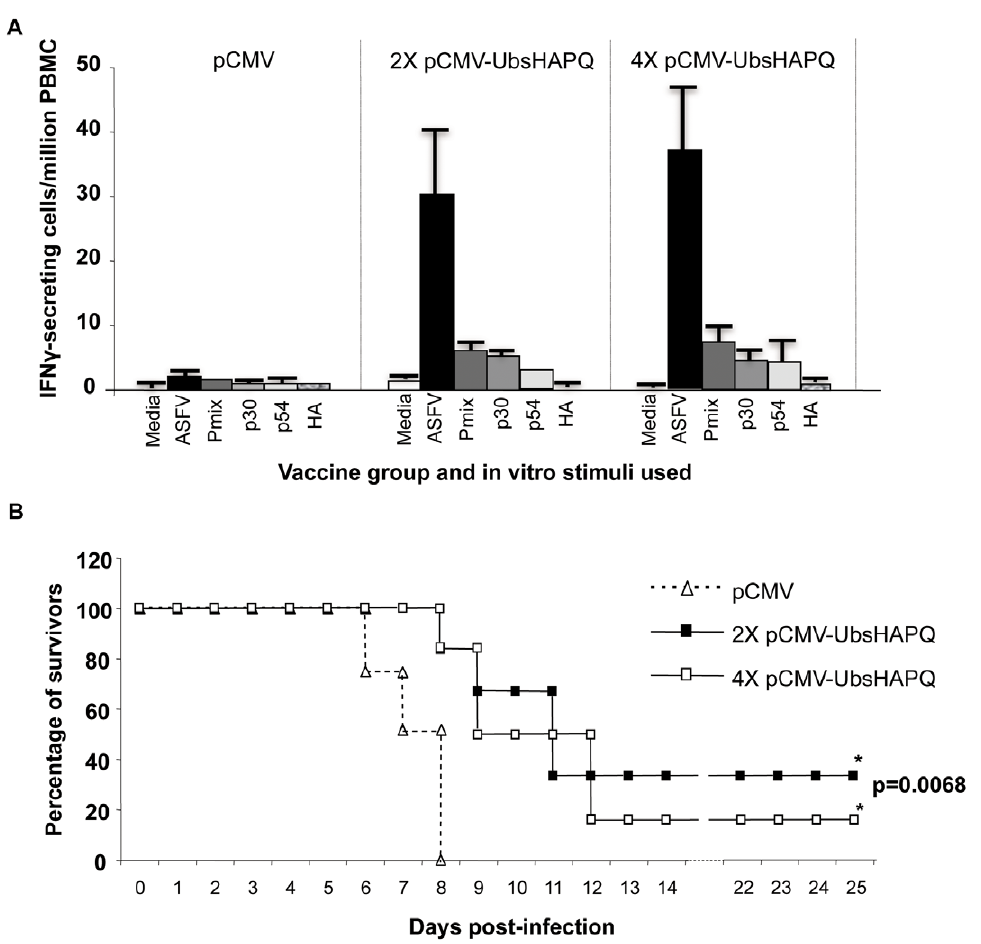
Figure 5. pCMV-UbsHAPQ protects against lethal ASFV challenge. (A) PBMCs from pigs immunized twice (2x) or 4 times (4x) with pCMV- UbsHAPQ or with pCMV, were in vitro stimulated with media (negative control), with the E75 ASFV isolate (10 5 HAU 50 /ml), with a mix of the p54, p30 and HA ASFV proteins (6 m g/ml of each one) or with each one of these proteins individually. Values shown for each immunization group correspond to the average number of specific IFN c -secretory cells detected per million PBMCs. Standard deviations found within each group are also represented. (B) Immunized pigs were challenged with a lethal dose of ASFV (10 4 UHA of the E75 isolate) and survival record were plotted. Groups immunized with pCMV-UbsHAPQ showed statistically significant differences (*) when compared with the control group (p=0.0068).